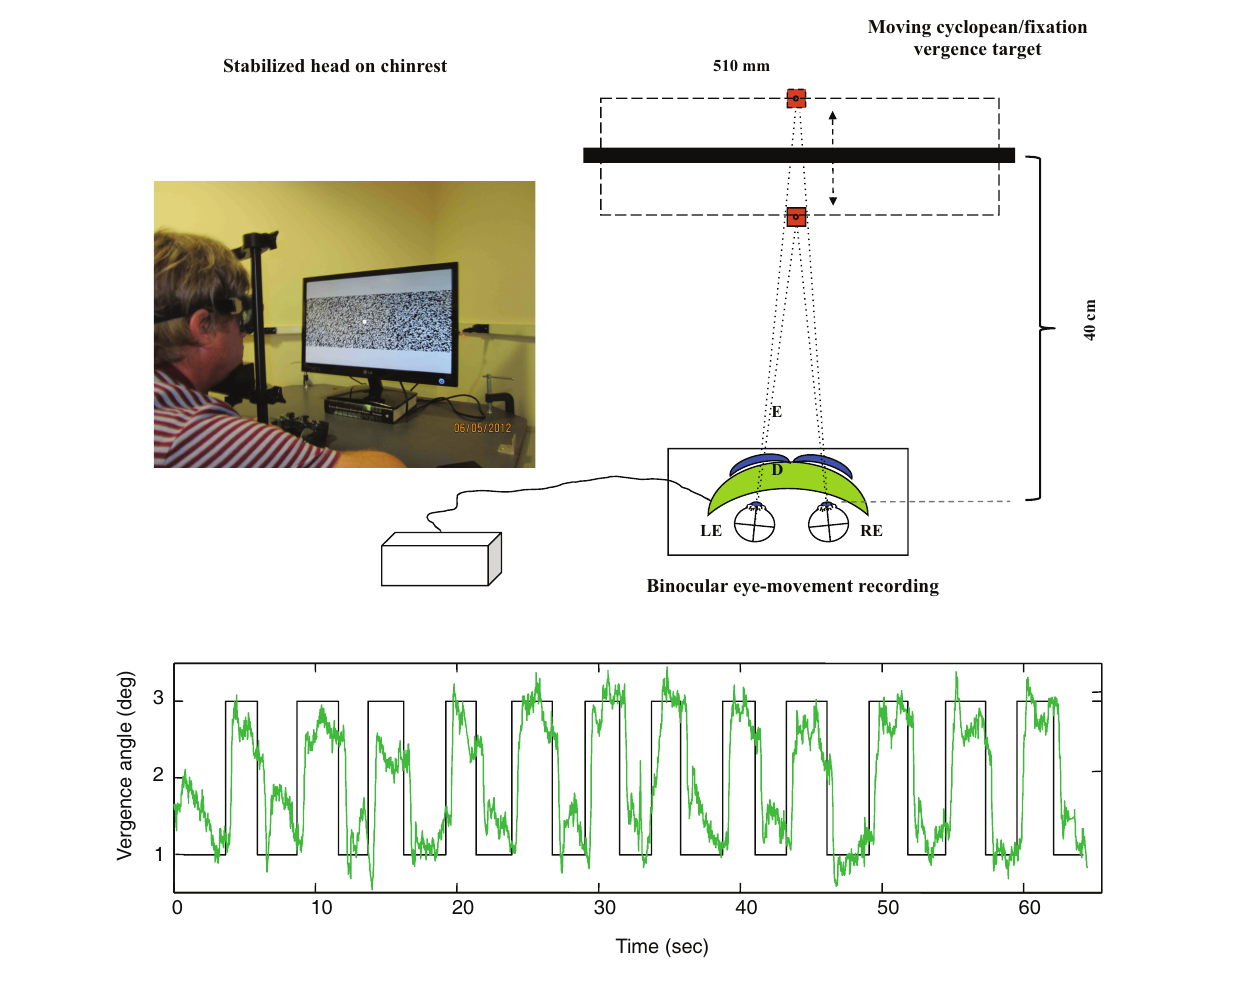
series of vergence eye movements alternating far (1° disparity) and near (3° disparity) to a series of disparity jumps separated by randomized delays of 2–3s. Note that compressed y -axis scale compared with Figure 3 . There is non-systematic vergence drift of the order of 0.5° between the step vergence